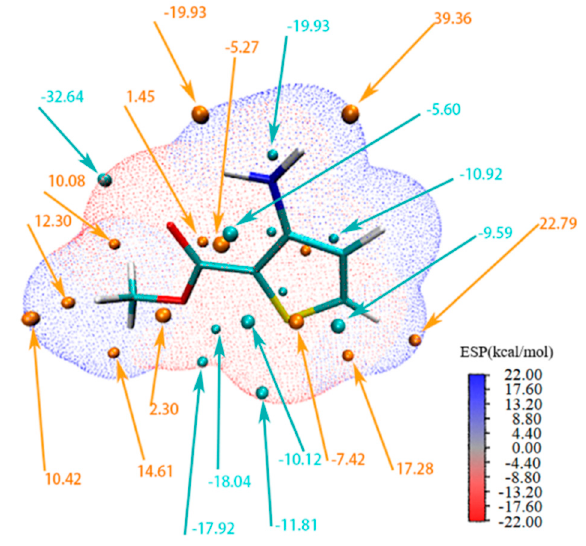
Figure 7. ESP-mapped molecular vdW surface of matc ( ρ = 0.001 e/bohr 3 ).